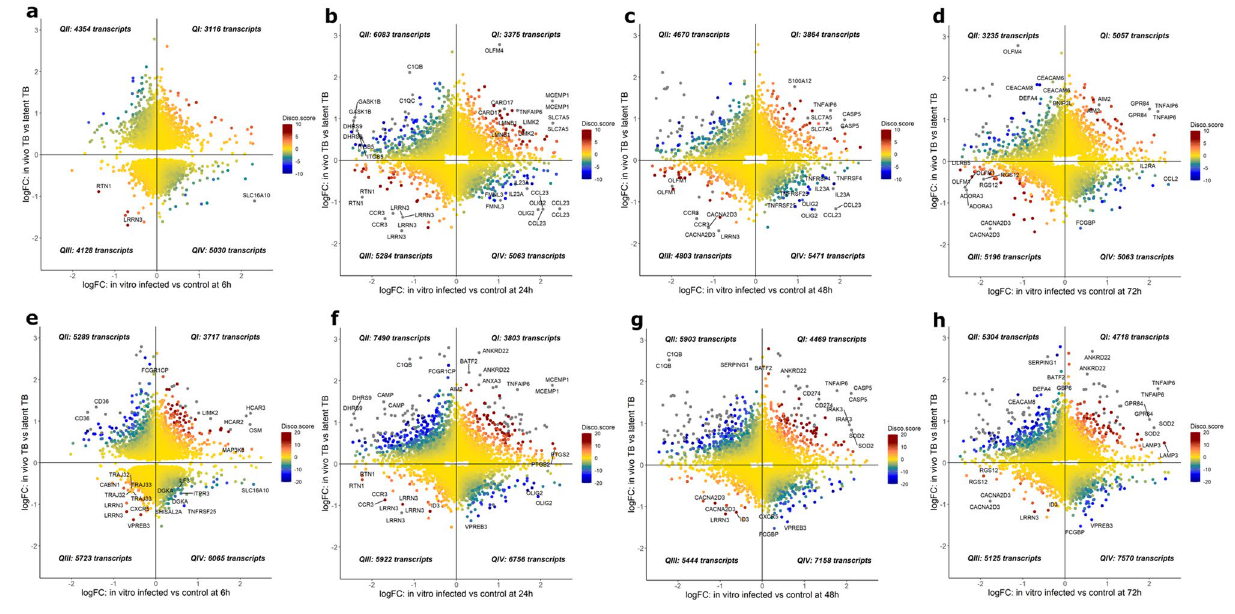
Figure 2. Disco plots. ( a – d ) Evaluation of concordance of gene expression changes in adult TB and in vitro time series ( a = 6 h, b = 24 h, c = 49 h and d = 96 h). Disco.score shown by colour intensity, ranging from blue (low concordance) to dark red (high concordance). Transcripts found in each disco plot are segmented into four quadrants (Q) as follows; QI—concordantly upregulated, QII—discordant, upregulated in vivo & downregulated in vitro, QIII—concordantly downregulated and QIV—discordant, downregulated in vivo and upregulated in vitro. Numbers of identified transcripts shown in each quadrant. ( e – h ) Evaluation of concordance of gene expression changes in paediatric TB and in vitro time series ( e = 6 h, f = 24 h, g = 48 h, h = 72 h).